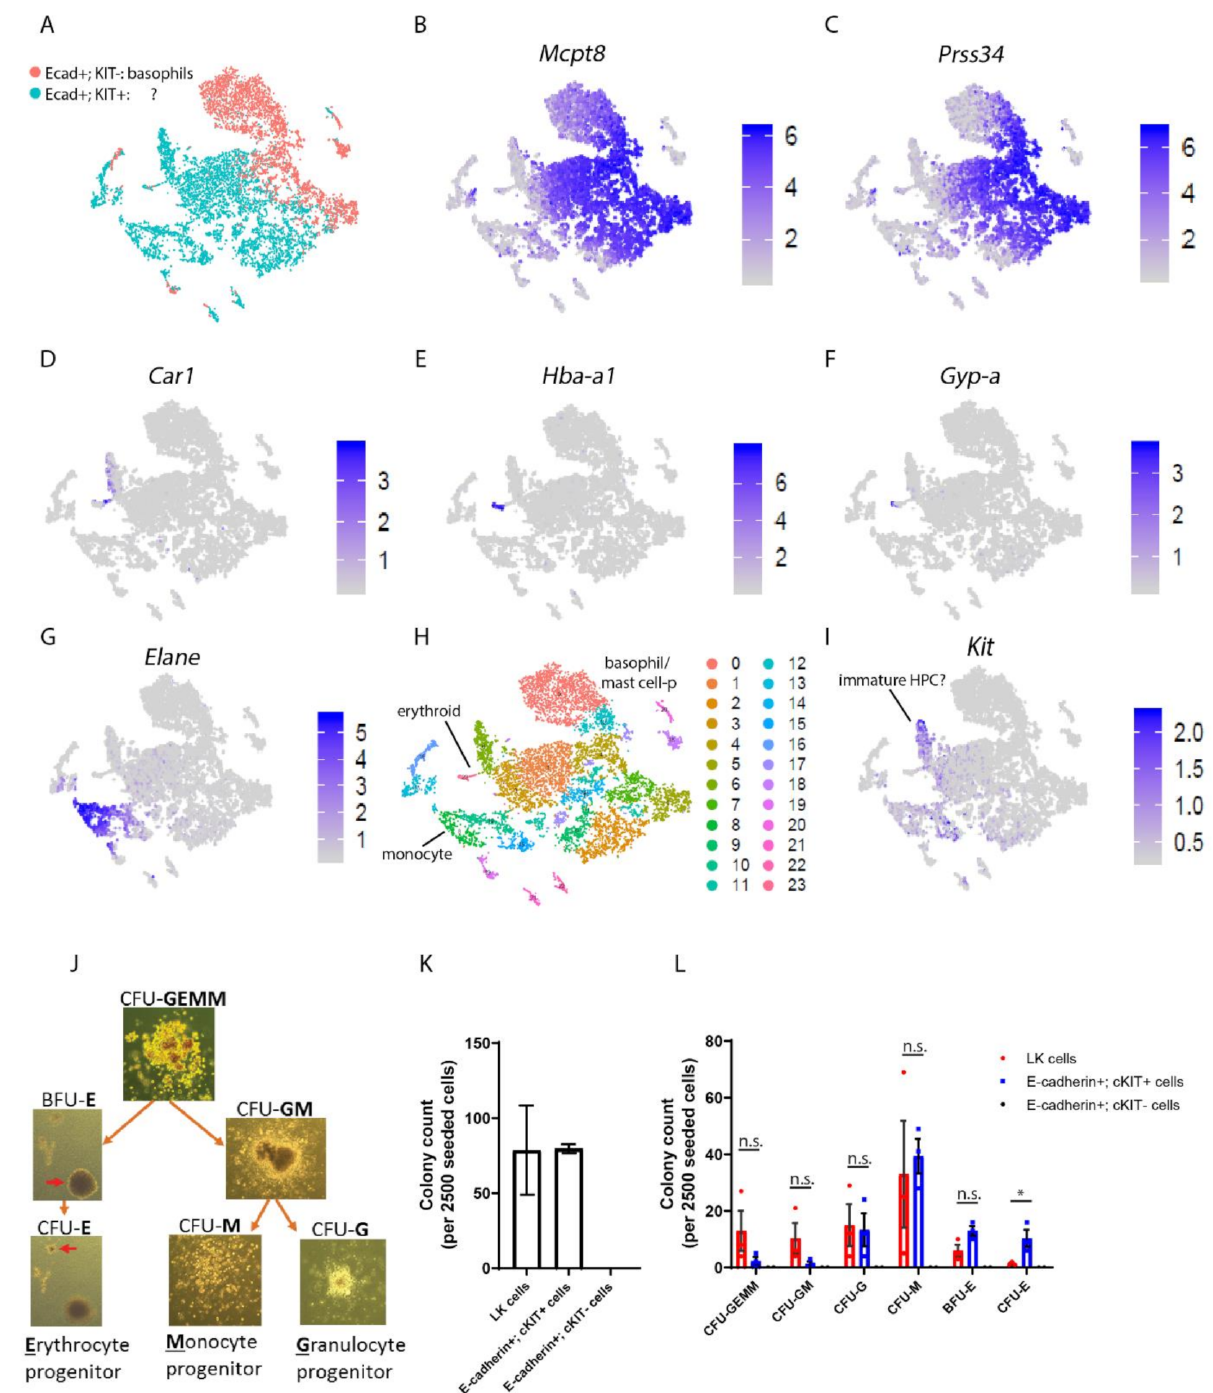
Figure 2. E-cadherin marks late hematopoietic progenitors and basophil/mast cell precursors in